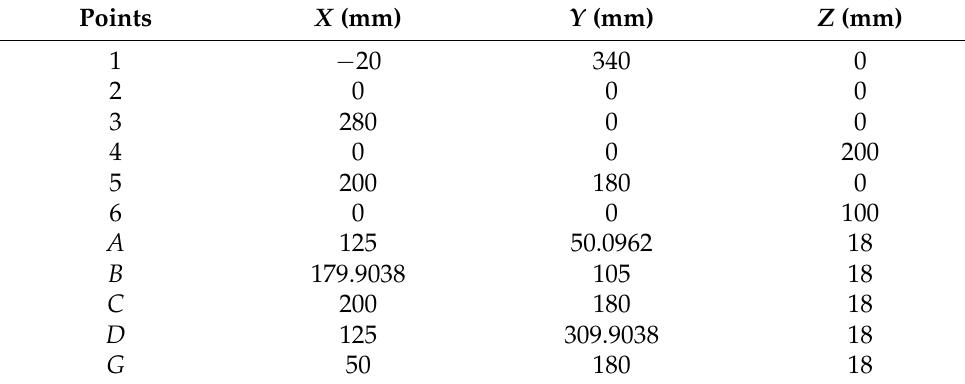
Table 2. Point 2 is the coordinate origin of the spatial coordinate system. Table 2. The object space coordinates of first